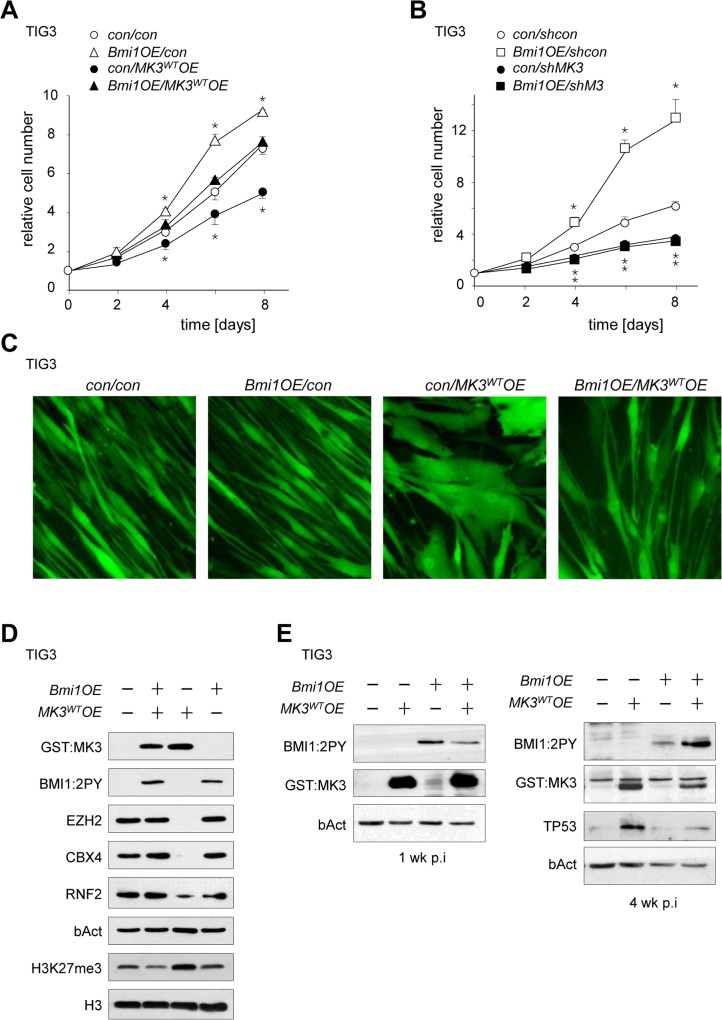
Functional links between MK3 and PRC in proliferative life span.TIG3 cells were sequentially transduced with either Bmi1.ires.GFP (Bmi1OE) or GFP (con) virus, and MK3/puromycin (MK3OE) or control puromycin virus (con) at 48 hrs intervals. Retroviral vectors expressing murine Bmi1/GFP reporter were transduced first (or empty vector control), followed by a MK3/puromycin resistance marker (or empty vector control). Transduction of Bmi1OE and control transduced cells was simultaneously carried out with the same MK3
WT
OE viral preparation (or control virus) to minimize inter-experimental variation. Cells were grown on selection medium and proliferation capacity was tested ± 2–3 weeks post-transduction. (A) Proliferation curves of normal human TIG3 fibroblasts transduced with a retroviral MK3
WT
overexpression vector (MK3
WT
OE; black symbols) or shcon vector (white symbols), in conjunction with either an empty vector control (con; circles) or a murine Bmi1 expression vector (Bmi1OE; triangles). (B) Proliferation curves of normal human TIG3 fibroblasts transduced with a retroviral MK3 knock-down vector (shMK3; black symbols) or shcon vector (white symbols), in conjunction with either an empty vector control (con; circles) or a murine Bmi1 expression vector (Bmi1OE; squares). Cell counts at t = 2 through t = 8 (A, B) were normalized to cell counts at t = 0 for each transduced cell culture individually (see Methods section for details); statistical significance was determined by two-tailed Student’s t-test and is presented relative to the empty vector control (* p < 0.05). (C) Comparative morphology of TIG3 cells expression Bmi1 and/or MK3 versus control cells as recorded by GFP fluorescent imaging ± 3 weeks after transduction (D) Immunoblot analysis of EZH2, CBX4, RNF2 and H3K27me3 in MK3
WT
OE, Bmi1OE, Bmi1OE/MK3
WT
OE and control TIG3 cell lysates. (E) Expression analysis of BMI1, MK3, and TP53 at the indicated time points in (corresponding to experiment in Fig 4C). Cells were grown on selection medium and analysed at 1 or 4 weeks after serial transduction; expression vectors and antibodies are indicated in the figure. Early and late samples were loaded on the same gel for BMI1 analysis; corresponding sections are shown separately.